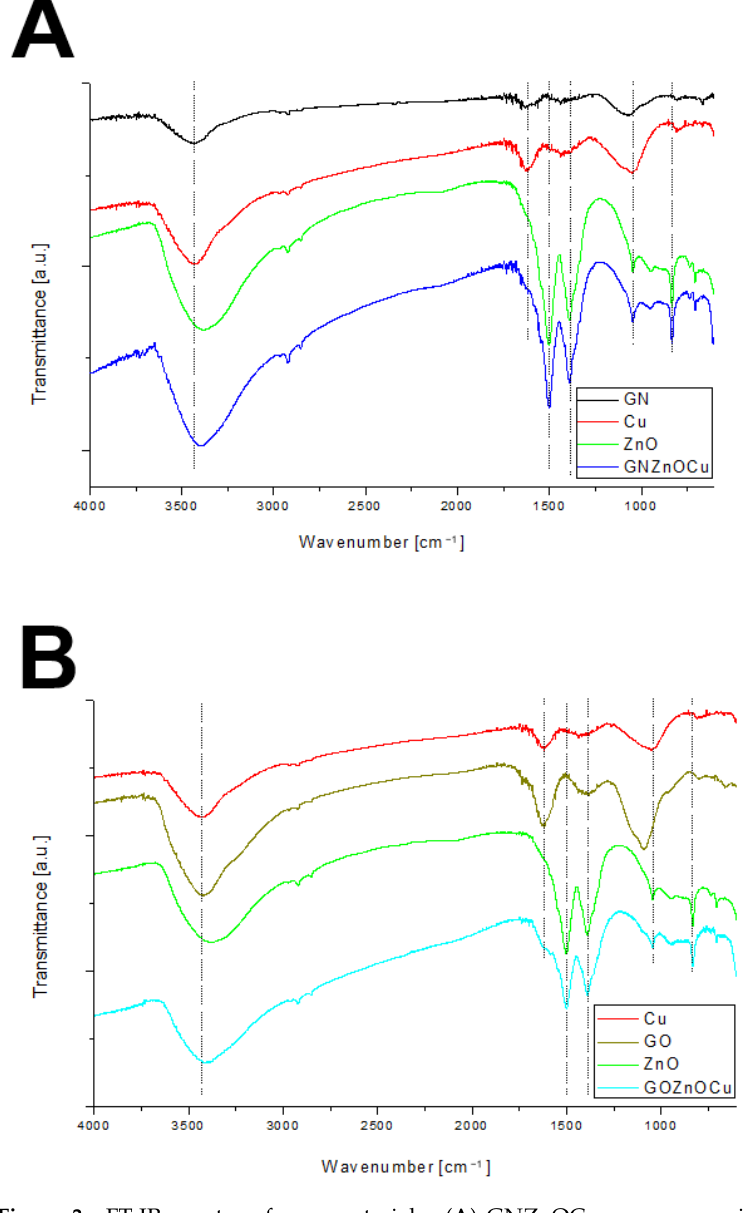
Figure 3. FT-IR spectra of nanomaterials: ( A ) GNZnOCu nanocomposite and its components; ( B ) GOZnOCu and its components.